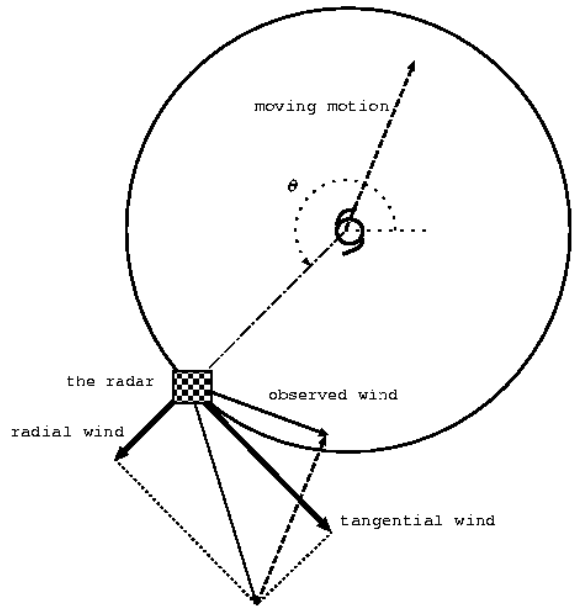
Fig. 1. Schematic illustration of analysis method based on an as- sumption of an axi-symmetrical structure of the typhoon. Rectan- gle shows radar position. Thin solid, broken, and thick solid vectors indicate horizontal wind observed by radar, moving speed of the ty- phoon center, and tangential and radial components,